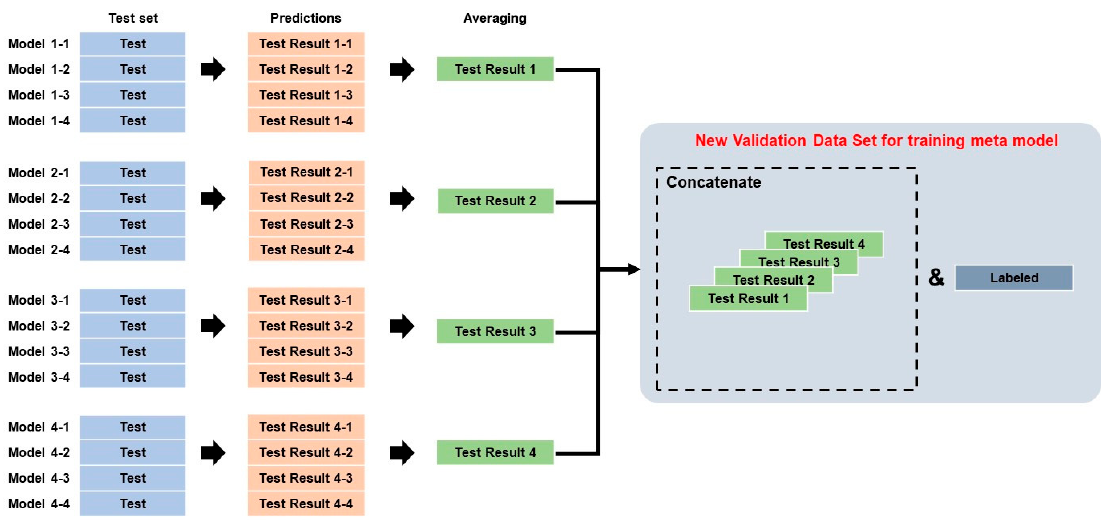
Figure 8. Strategy of training data generation for metamodel by stacking ensemble: preparing training dataset.